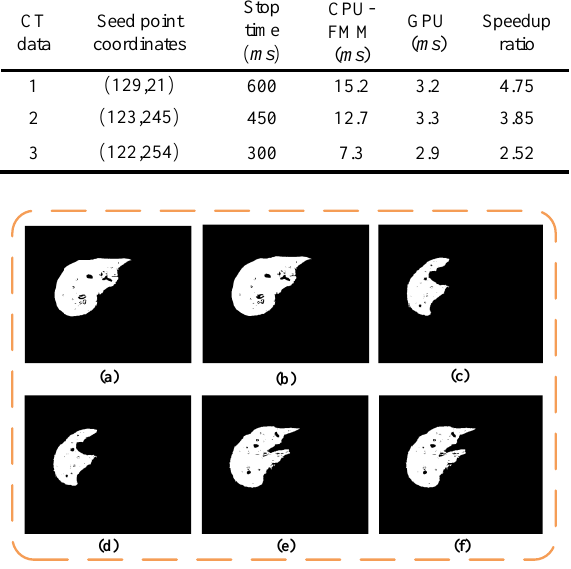
Figure 5. GPU vs. CPU segmentation